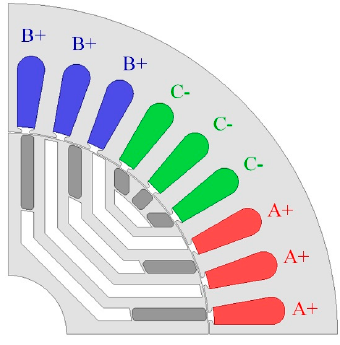
Figure 13. Final model of LS-SynRM. Table 7. FEA result of the final